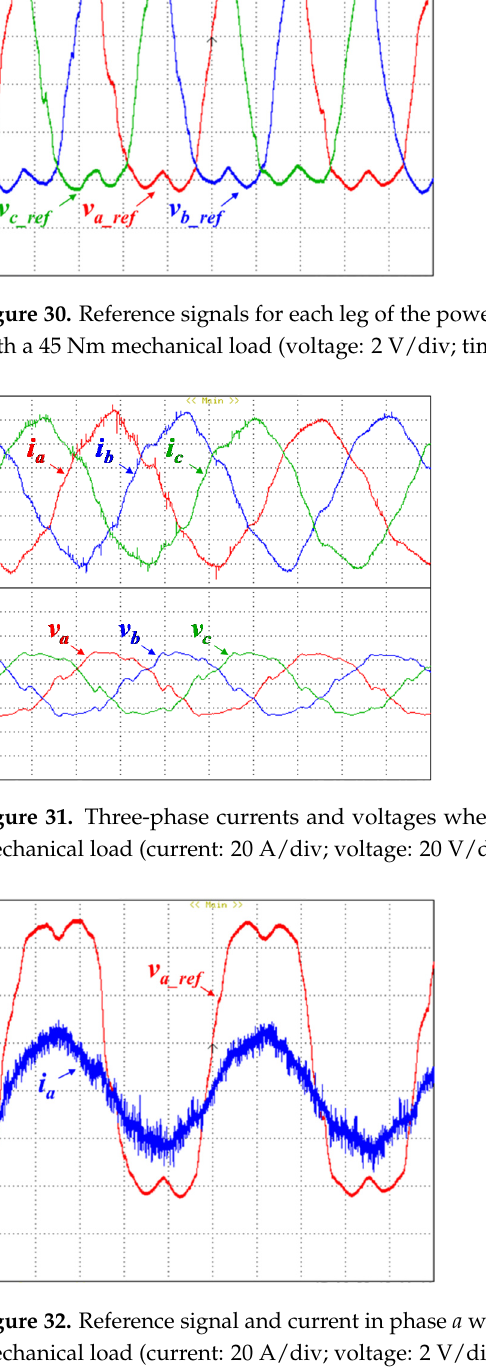
Figure 32. Reference signal and current in phase a when the electric machine operates with a 45 Nm mechanical load (current: 20 A/div; voltage: 2 V/div; time: 10 ms/div).